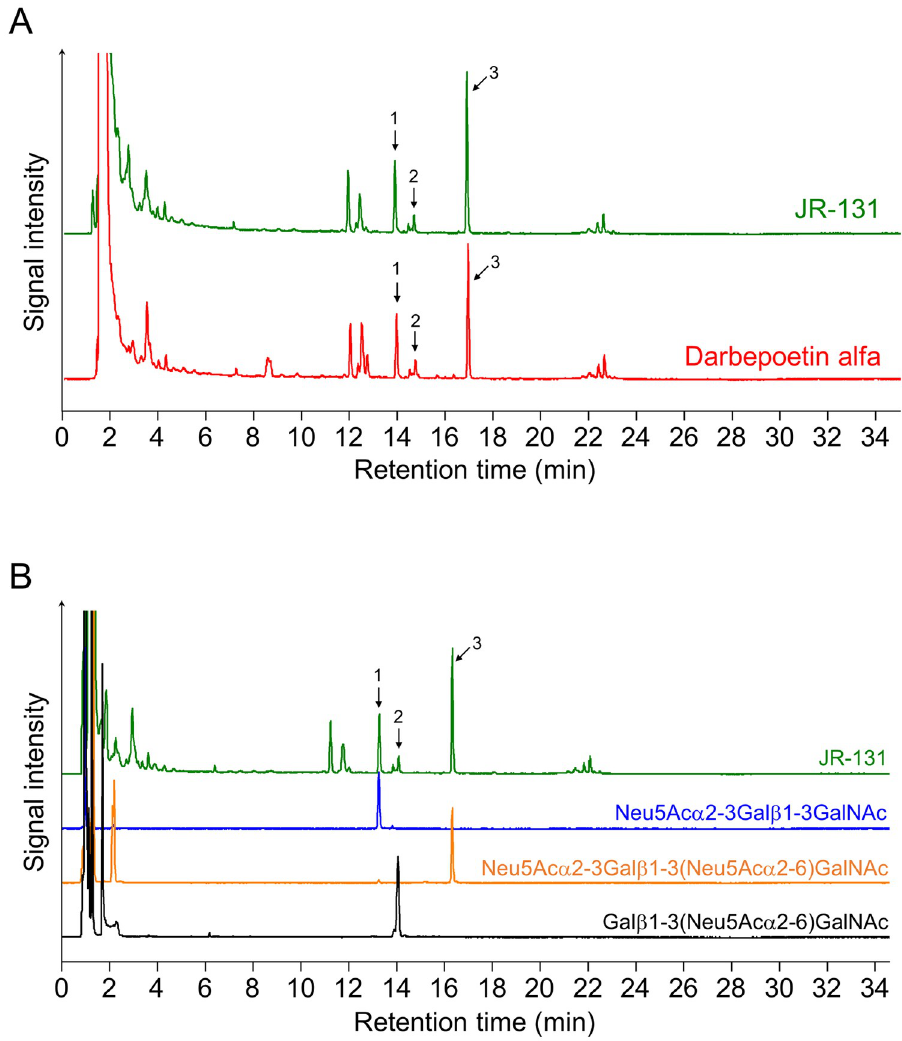
Fig 4. O -linked oligosaccharide profiles of JR-131 and darbepoetin alfa. (A) Overlaid chromatogram of O -linked oligosaccharide profiles of JR-131 and darbepoetin alfa. (B) Determination of the peaks. Gal β 1-3(Neu5Ac α 2–6) GalNAc was obtained by treatment of the standard glycan (2AB-labeled di-sialylated core 10 glycan) with α -2,3 sialidase.